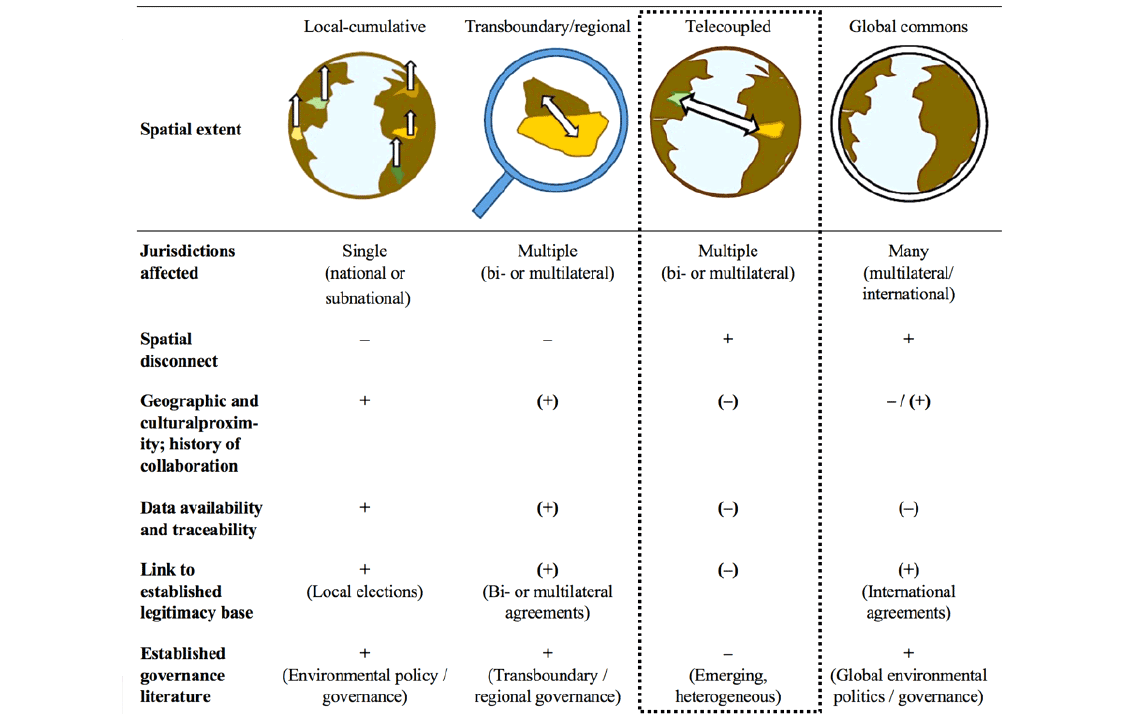
Fig. 1 . Environmental problems classified according to their spatial / jurisdictional extent. A + sign denotes that the criterion mentioned in the left column is of relevance to the spatial extent described; a – sign denotes that this is not the case; brackets denote that the criterion is somewhat important (+) or unimportant (–). The white arrows and the circle denote the spatial extent of the environmental